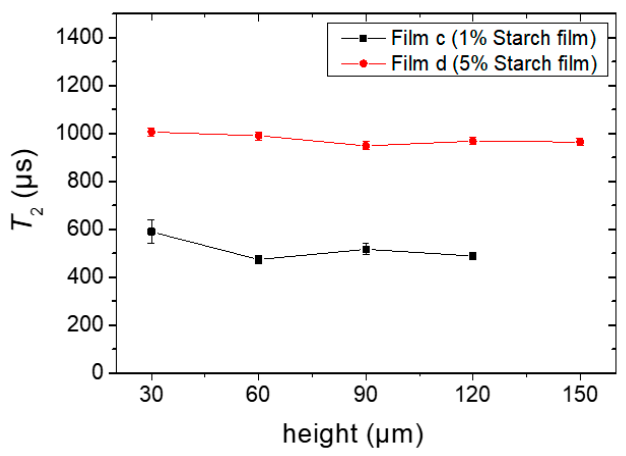
Figure 8. T 2 constants at different heights of the completely dried films c and d , prepared from Sample c containing 1% starch in H 2 O ( w / v ) and Sample d containing 5% starch in H 2 O ( w / v ), respectively. Glycerol (20 g/100 g of starch) was used as a plasticizer during film preparation.